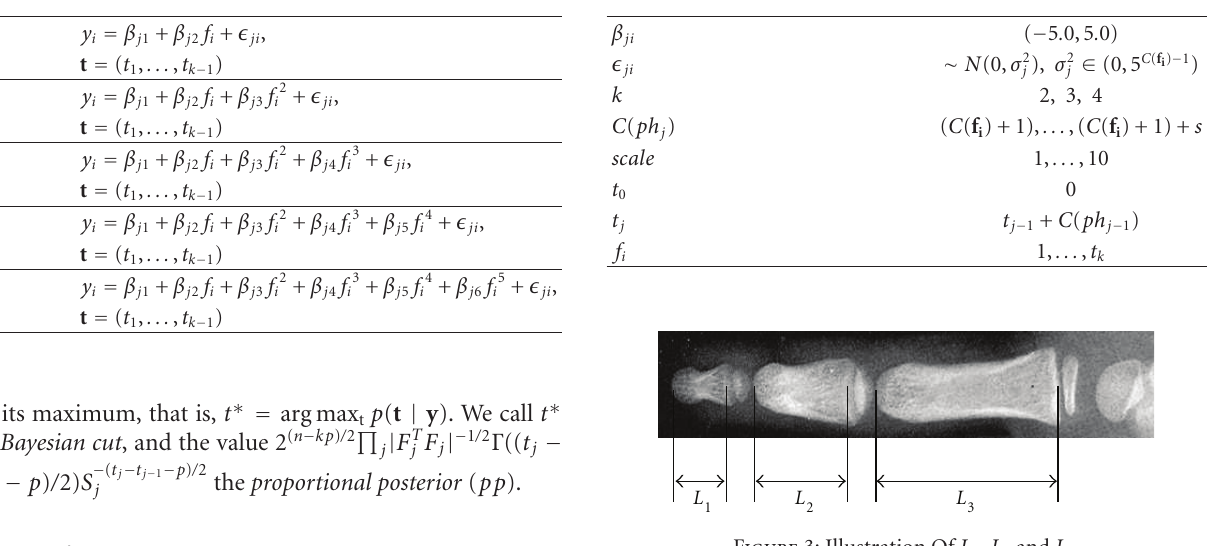
Table 1: Models for testing the performance of the Bayesian cut. Table 2: Experimental setting.